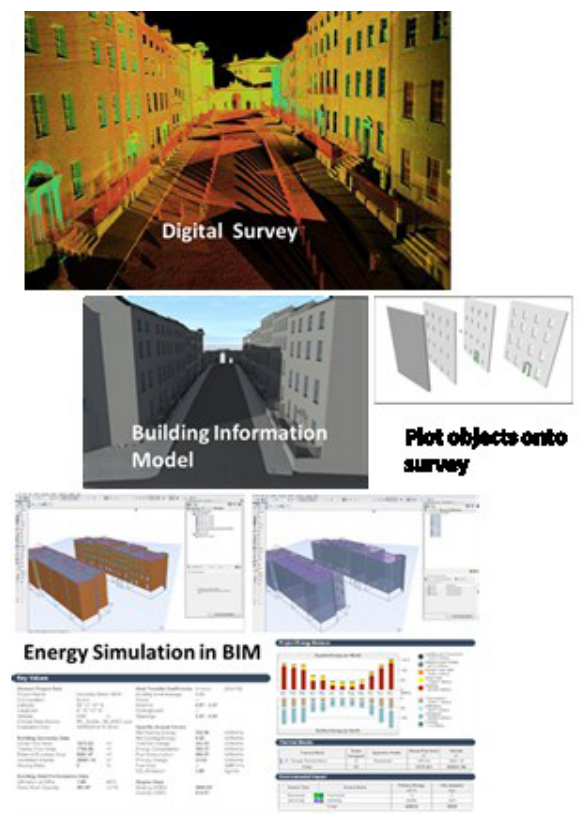
Figure 1: Scan to HBIM to Documentation (Dore & Murphy